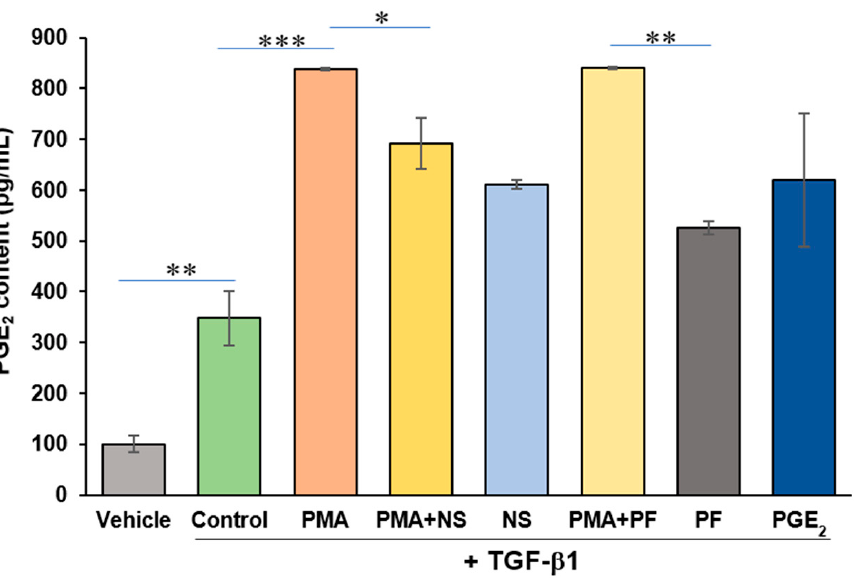
Figure 3. PGE 2 content in human cardiac myofibroblasts treated with PMA or other indicated agents. Levels of PGE 2 in the culture medium of cardiac myofibroblasts were measured using PGE 2 ELISA Monoclonal Kit. Samples and standards were assayed in parallel. All assays were performed in duplicate plates. The results were calculated according to the standard curve of PGE 2 and expressed as pg/mL. PMA: phorbol 12-myristate 13-acetate; NS: NS-398 (a selective COX-2 inhibitor); PF: PF-04418948 (a selective EP2 receptor antagonist). Data were expressed as mean ± S.E.M. n = 4/per group. * p < 0.05, ** p < 0.01, *** p <